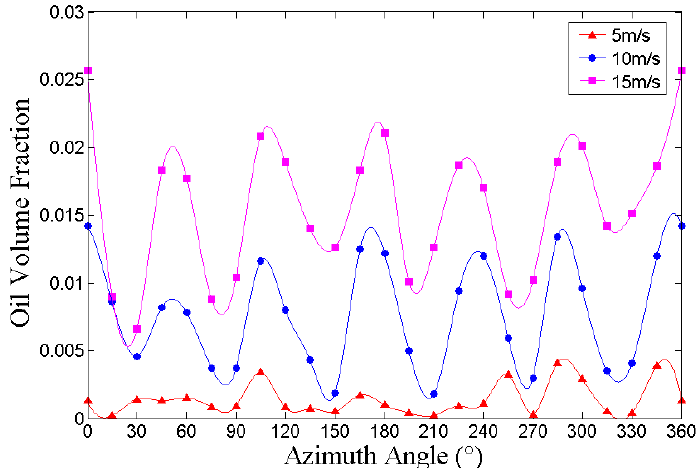
Figure 8. Oil volume fraction around the circumference with different oil inlet velocities.